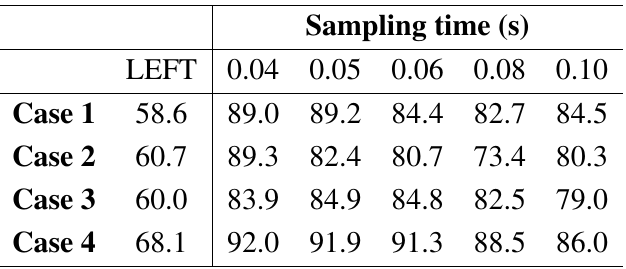
Table 6. Comparison of recognition accuracy (%) of user identification by stepping